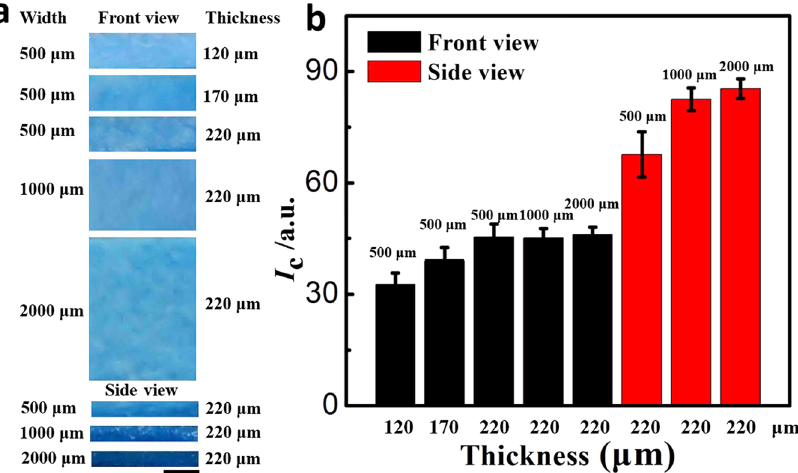
Figure 3. ( a ) Photographs showing the side and front views of three types of paper channels after introduction of 0.010 M coomassie brilliant blue solution. The widths and thickness of the paper strips used to fabricate the channel are indicated. Scale bar: 0.5 mm ( b ) Color intensity ( I c) of the channels measured from these